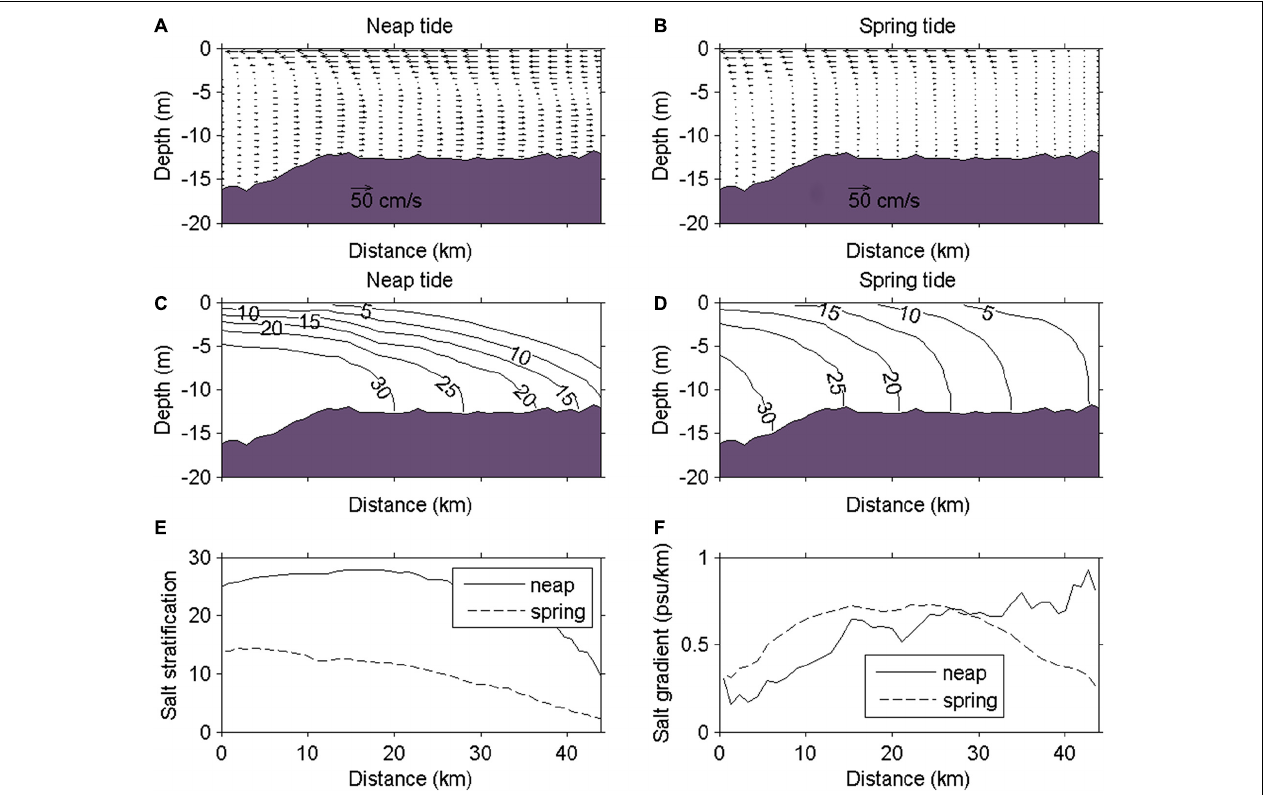
FIGURE 3 | Subtidal along-channel current velocity (cm/s) at maximal (A) neap and (B) spring tides, subtidal salinity at maximal (C) neap and (D) spring tides, and subtidal salinity stratification (E) and along-channel salt gradient (F) at maximal neap and spring tides along the west deep channel. The x-axis represents the distance from the mouth (0 km) to the head (44 km) of the